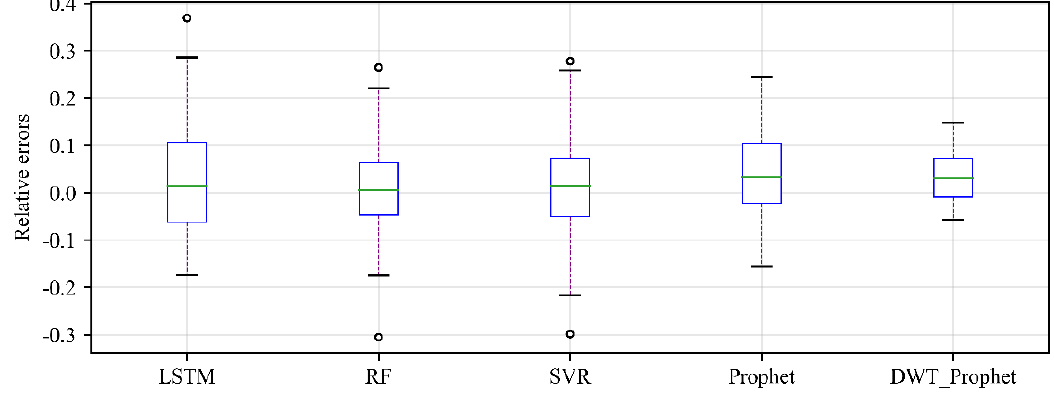
Figure 11. Comparison of the relative errors of the five models. A Taylor diagram is an effective method to evaluate the prediction performance of prediction models intuitively. As shown in Figure 12, the DWT – Prophet had the smallest RMSE and the largest correlation coefficient; moreover, it can be easily seen that the DWT – Prophet prediction value was closest to the observation value, which indicates that the DWT – Prophet had the best prediction performance.